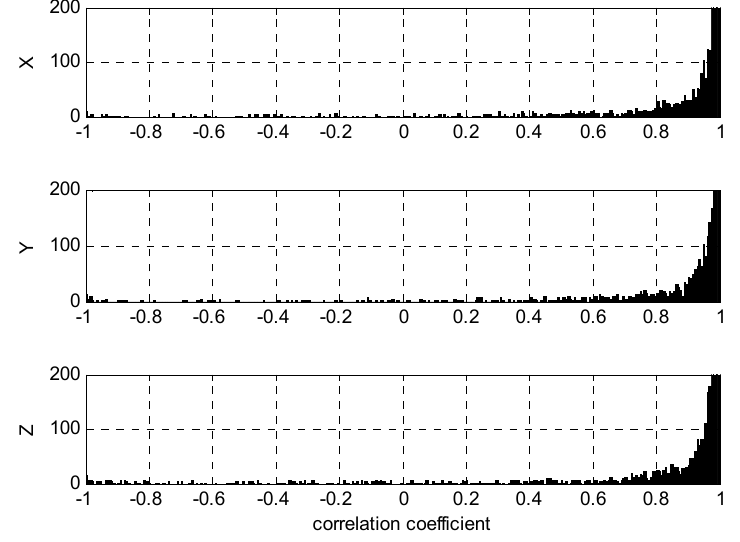
Figure 6. Histograms of correlation coefficients.